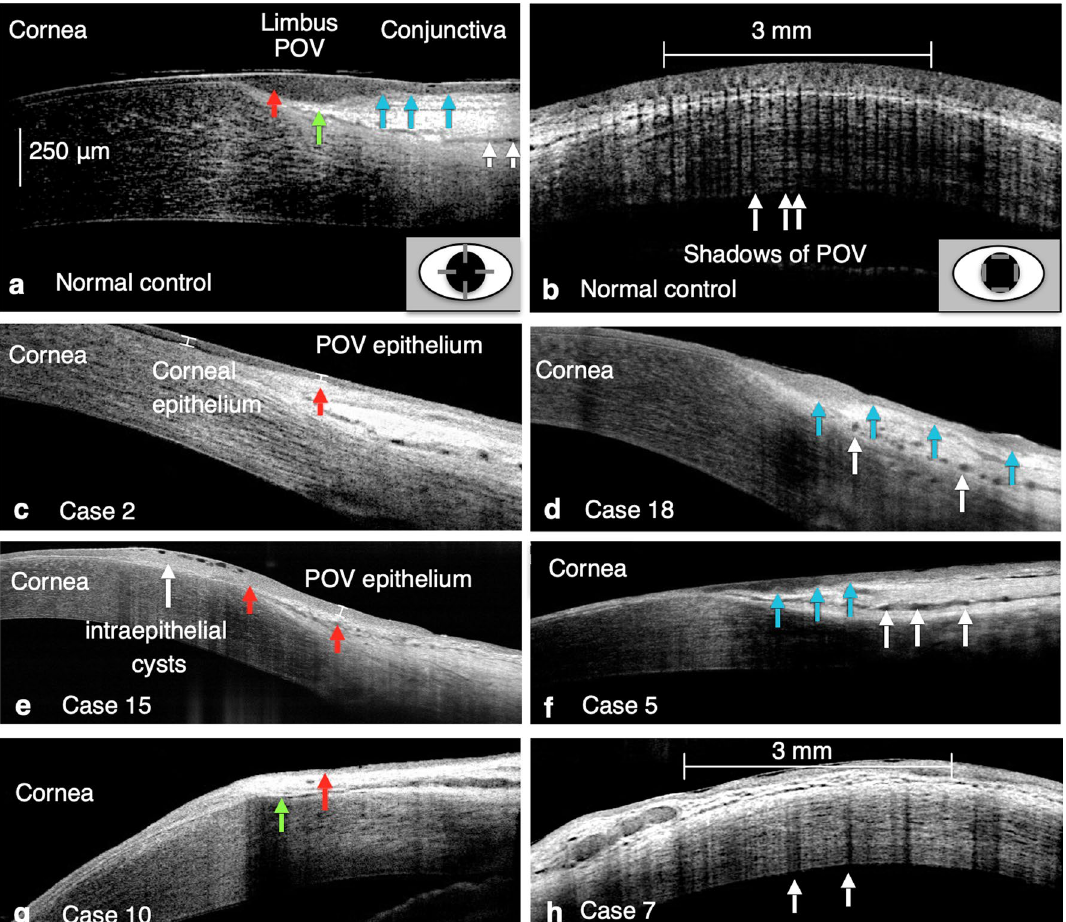
Figure 1. Patterns of the POV defined as “normal” or “abnormal” based on SD-OCT findings. (a) The radial cross-sectional scan of a 27-year-old healthy male participant showed following presentations. Red arrow: the maximum epithelial thickness of the POV was at least 1.5-fold greater than the central corneal epithelial thickness, and progressive tapering of epithelial thickness extending to the corneal and conjunctival sides was seen. Green arrow: sharp stromal tip of the POV pointing to the corneal–limbal junction. Blue arrows: a smooth epithelial–stromal interface. White arrows: limbal stromal vessels with lumen diameters < 50 μm. (b) The tangential cross-sectional scan showed dense, distinct shadows of the POV with regular intervals in the same participant as (a) . The central 3-mm width of scanned images (white line) was calculated. In this photo, the calculated density was 8.3 shadow/mm. White arrows indicate the location and shadows of the POV. The right lower figures in (a,b) indicate the scanning area and orientations (gray lines) in radial and tangential cross-sectional scans. (c) Representative figure of the decreased epithelial thickness of the POV in the radial cross-sectional scan. The maximum epithelial thickness of the POV (red arrow) was lower than the peripheral corneal epithelial thickness (Case 2, right superior limbus). (d) The radial cross-sectional scan showed loss of the smooth epithelial–stromal interface of the POV (blue arrows). Dilated limbal stromal vessels were also found (white arrows) (Case 18, left superior limbus). (e) Another figure showing abnormal epithelial thickness of the POV in a radial cross-sectional scan. The epithelium of the POV showed atypical tapering of thickness extending to corneal and conjunctival sides (red arrows). Intraepithelial cysts were also found in this case (Case 15, left nasal limbus). (f) Another representative figure of the uneven epithelial–stromal interface of the POV (blue arrows) showed in a radial cross-sectional scan. Dilated limbal stromal vessels were also found (white arrows) (Case 5, left superior limbus). (g) Loss of the typical sharp stromal tip of the POV (green arrow) was seen with a decreased epithelial thickness of the POV (red arrow) in a radial cross-sectional scan (Case 10, right superior limbus). (h) A tangential cross-sectional scan showed loose shadows of the POV (white arrows) with a calculated density of POV of 2.7 shadow/mm (Case 7, left superior limbus). White arrows indicate the location of POV